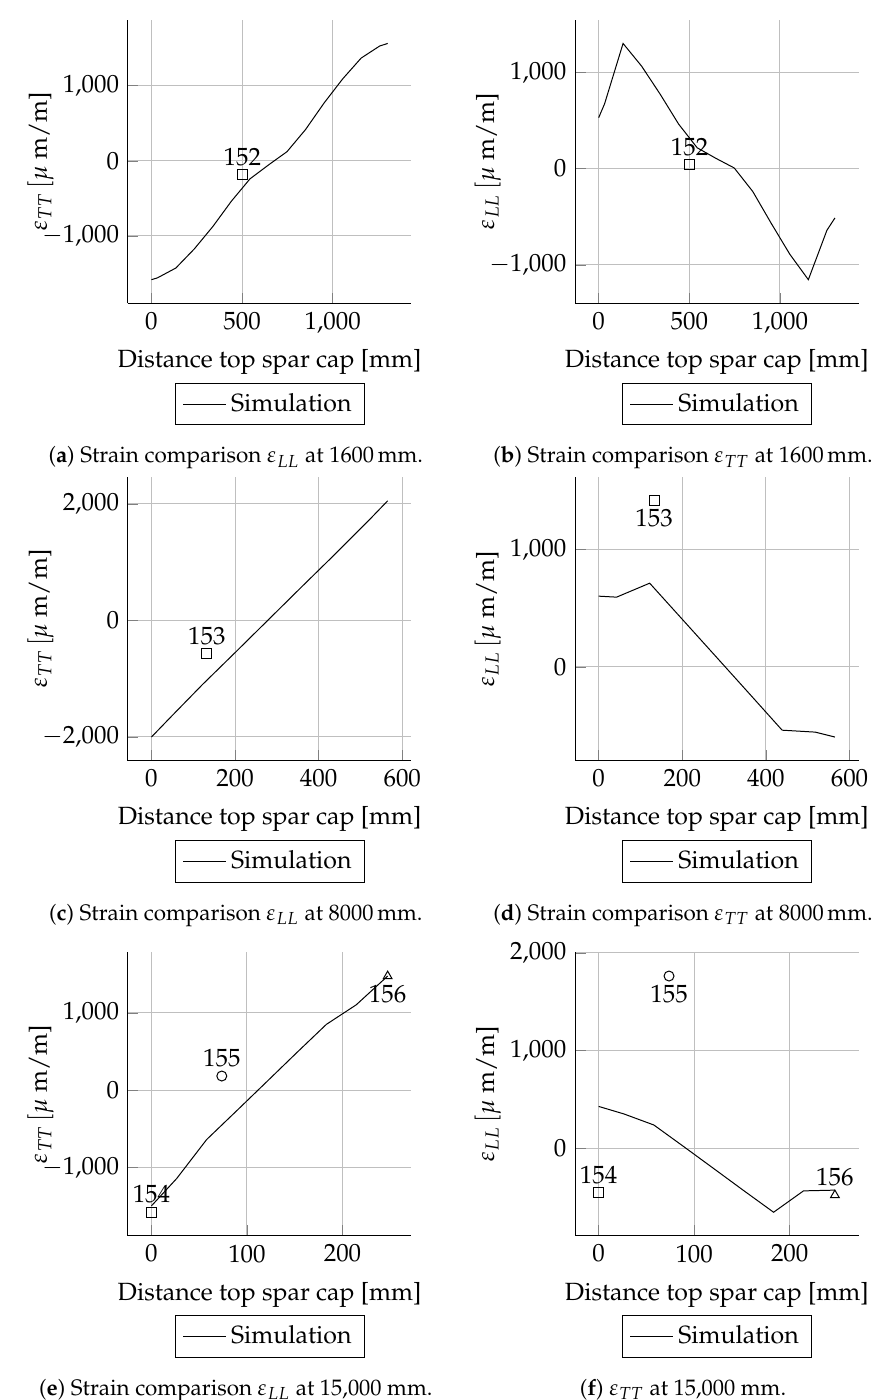
( e ) Strain comparison ε LL at 15,000 mm. ( f ) ε TT at 15,000 mm. Figure A39. Spar normal strains for MyMax load